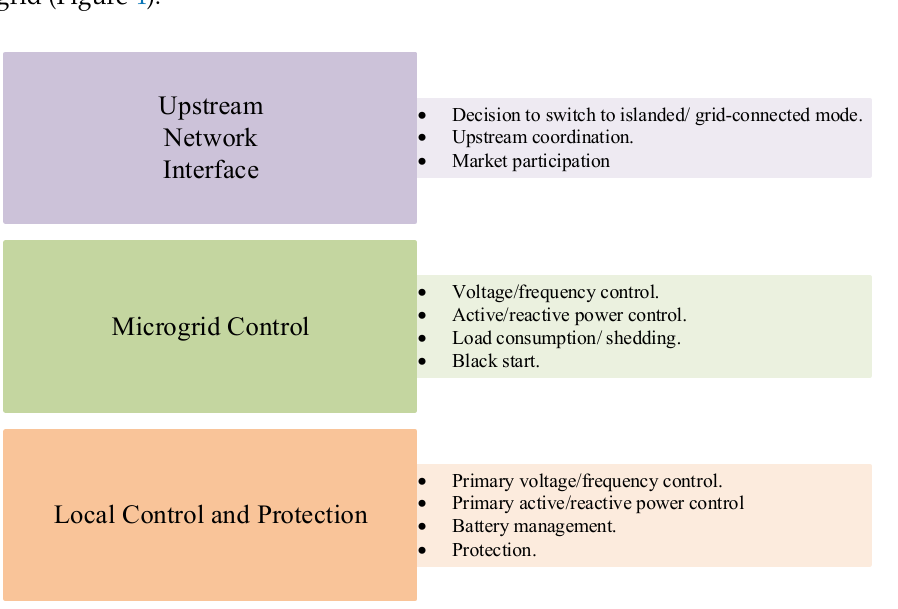
Figure 4. Separation by the level of tasks completed in the operation of microgrids.